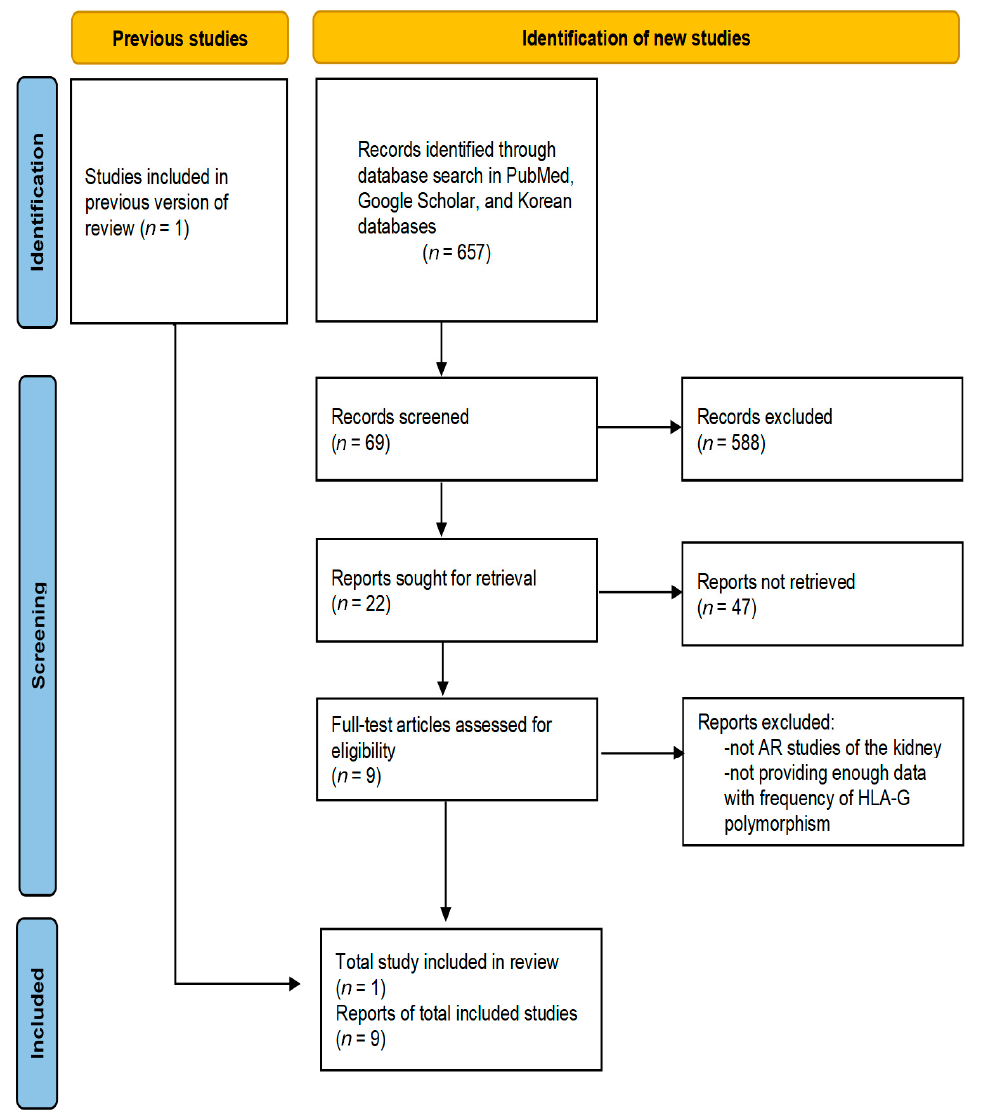
Figure 1. PRISMA flowchart in present study.